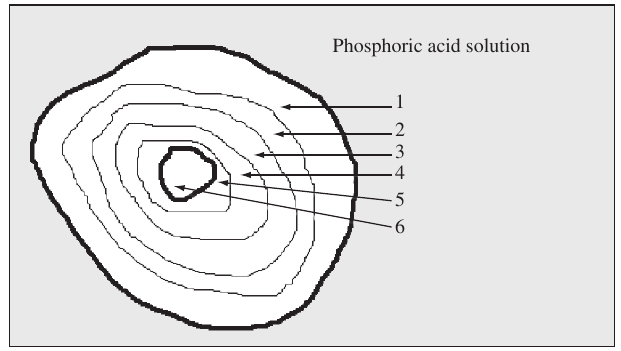
Figure 1. Partially reacted Ca(OH) gradient layers.